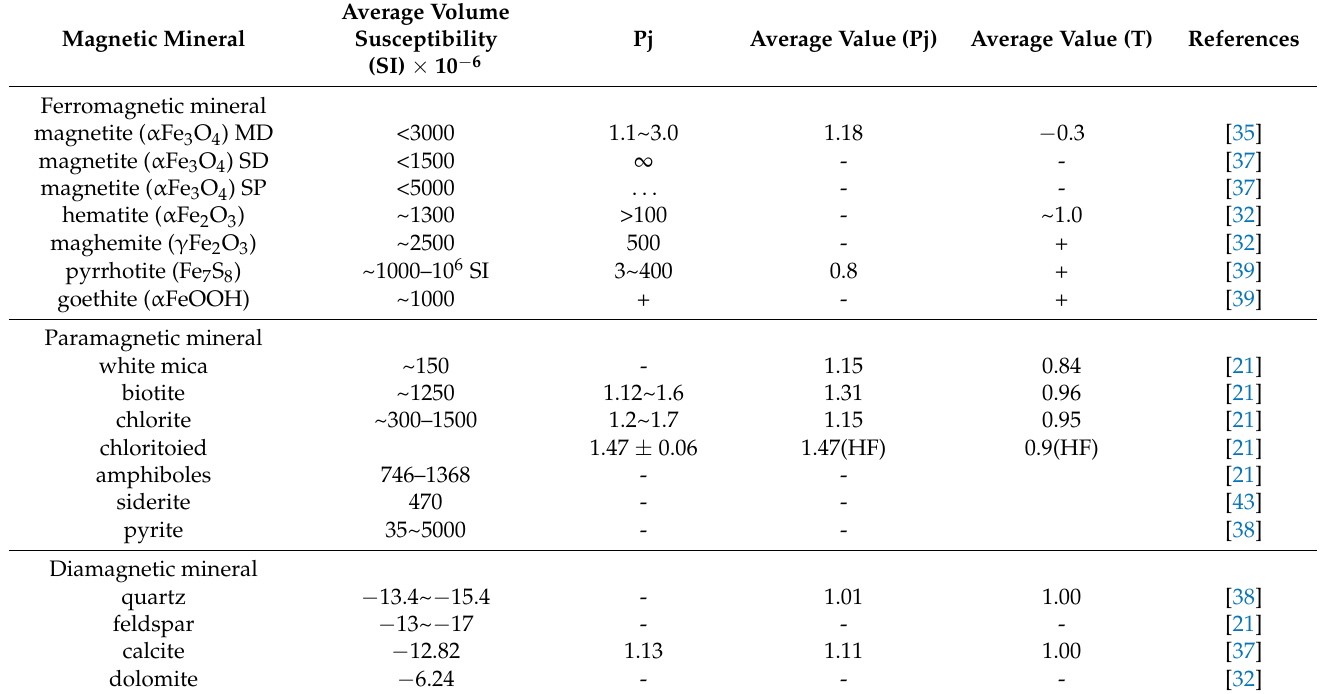
Table 2. Reference values of average magnetic susceptibility (Km), anisotropy (Pj) and shape factor (T) for common magnetic minerals